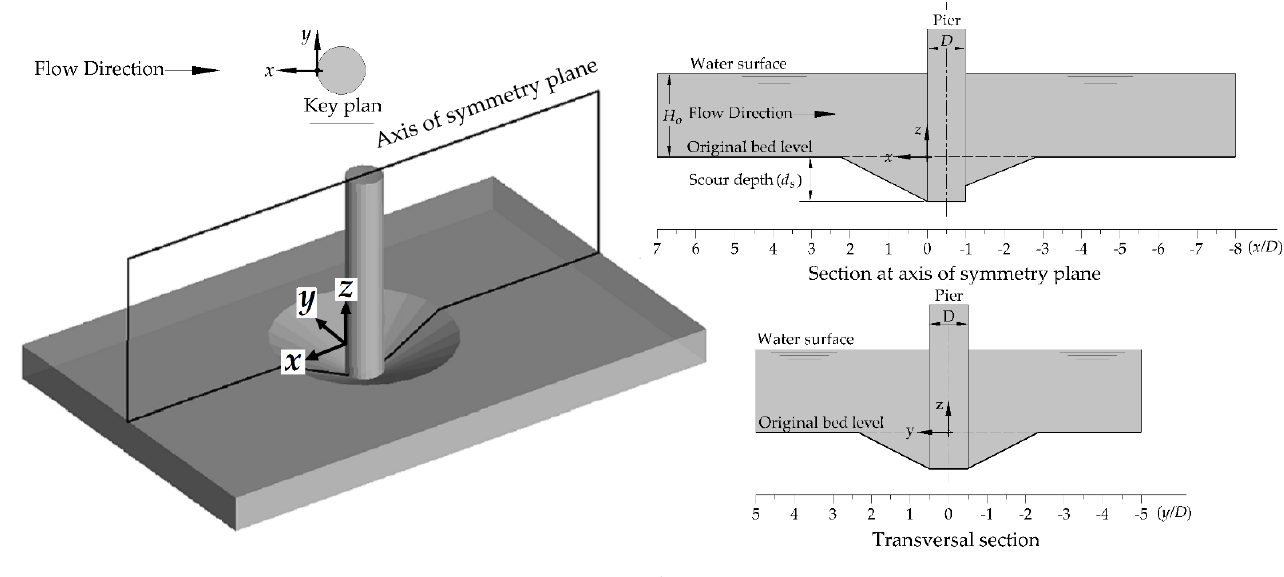
Figure 2. Variation of the scour hole bed level at the plane of symmetry during the scour stages.